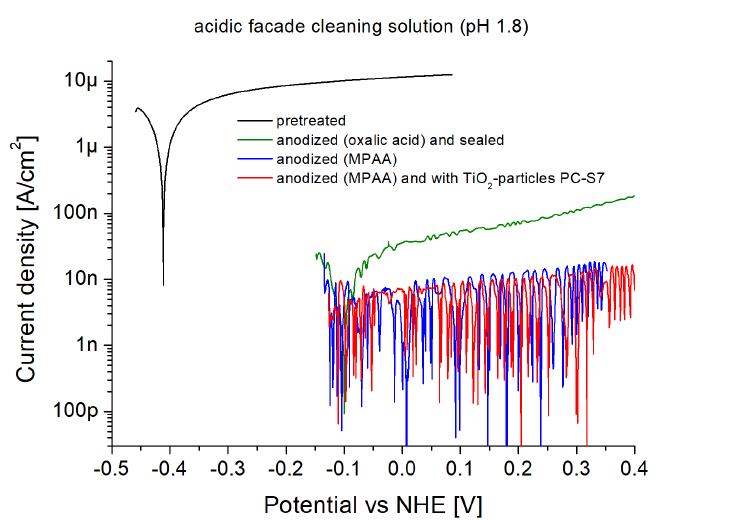
Figure 11. Potentiodynamic polarization curves of AlMg1 samples treated with different